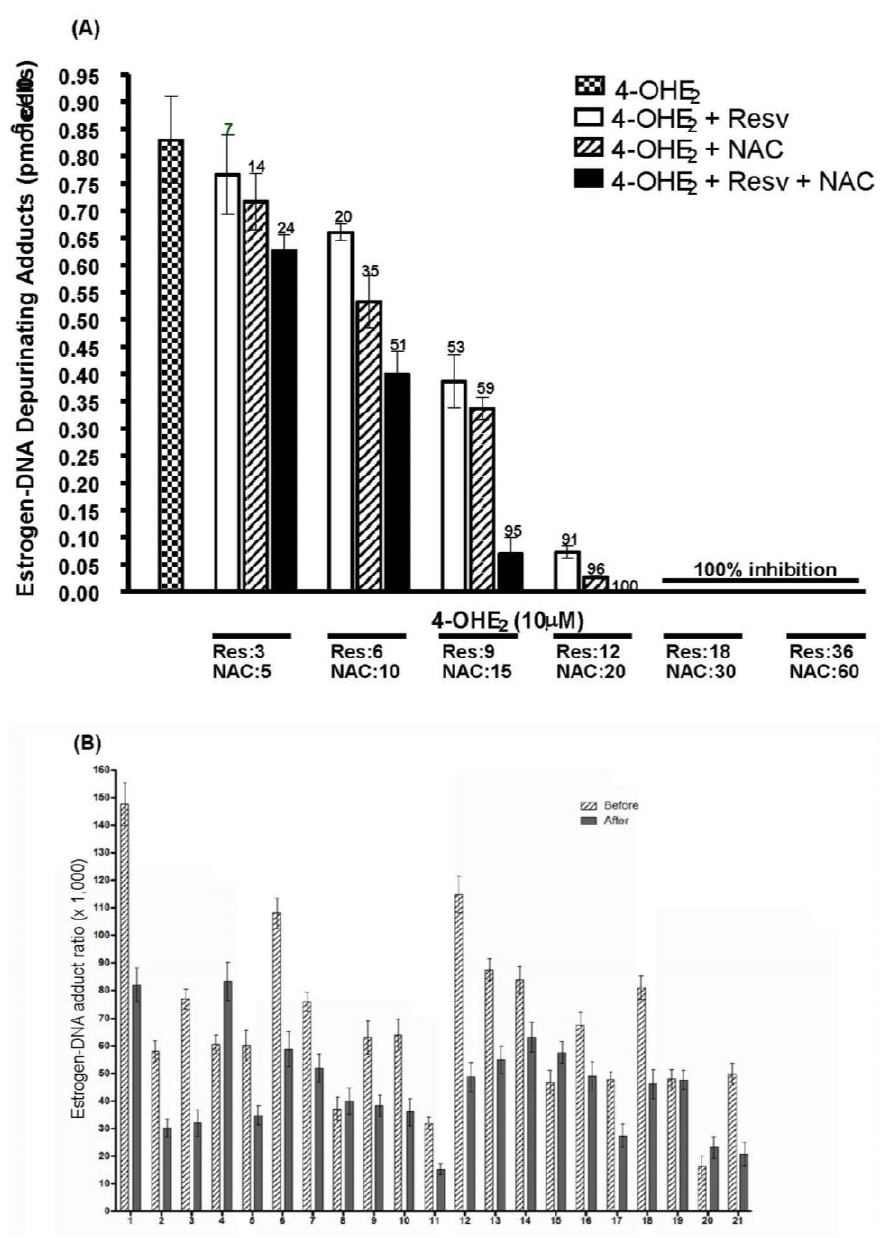
Figure 4. Inhibition of estrogen-DNA adduct formation by N -acetylcysteine and resveratrol in ( A ) MCF-10F cells treated with 4-OHE 2 [30]; and ( B ) urine from healthy women before and after 3 months of daily ingestion of the two compounds [56].